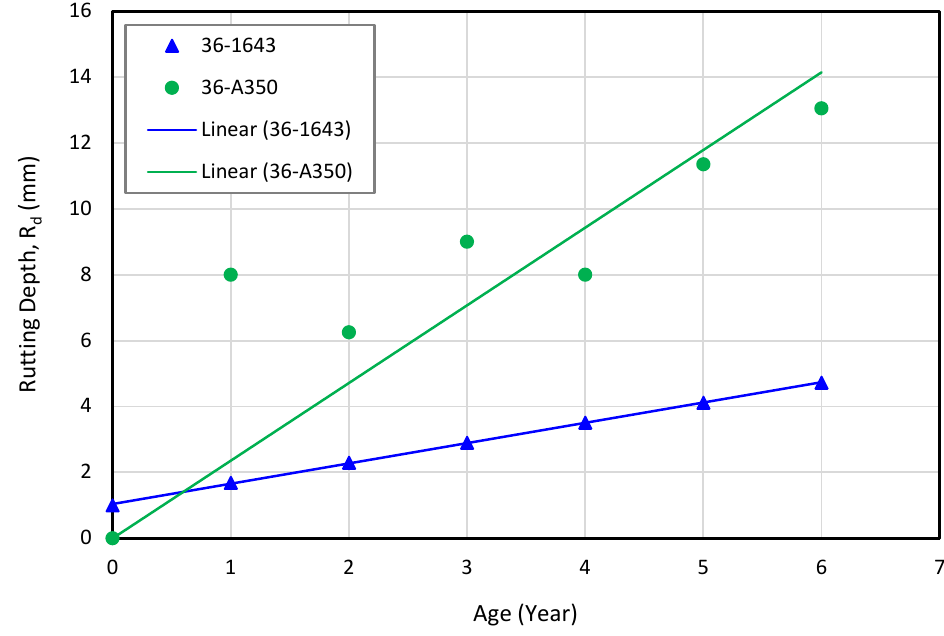
Figure 7. Rutting progression on the LTPP test sections located in